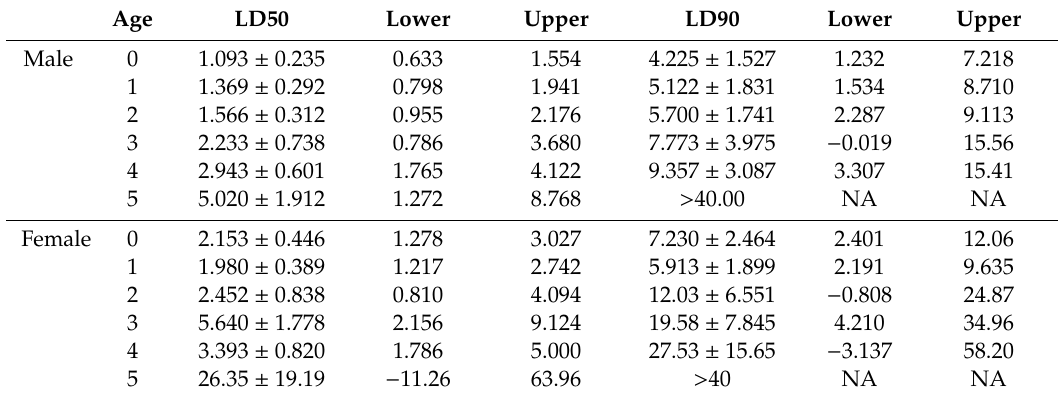
Table 4. Estimated lethal dose (LD) (% ACI) to achieve 50 and 90% of mortality in C. fumiferana pupae on which tebufenozide had been topically applied.